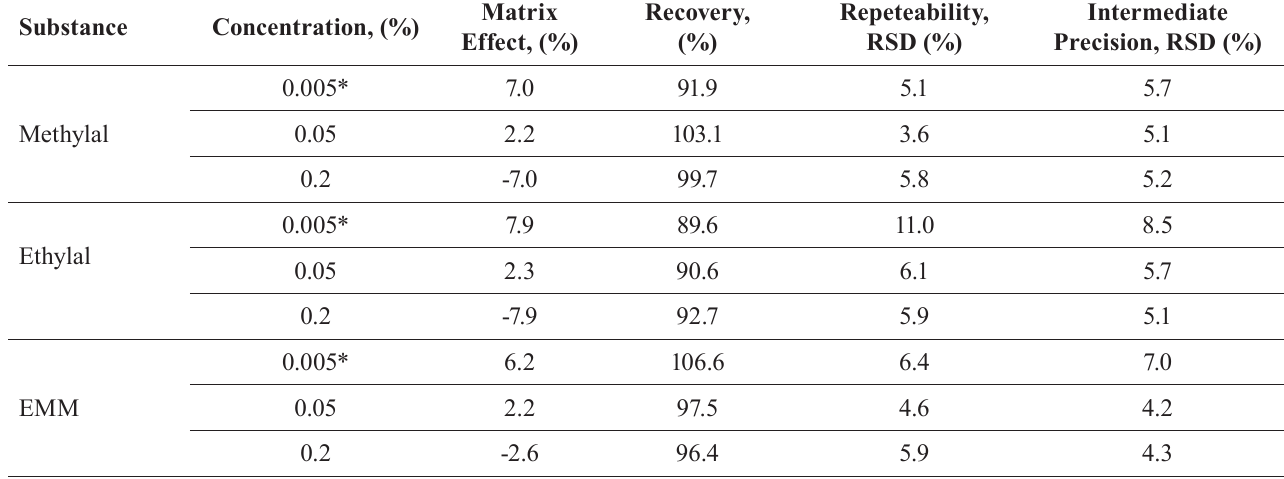
TABLE I - V alidation parameters for methylal, ethylal, and ethoxymethoxymethane (EMM) at three concentration levels (n=3 at each